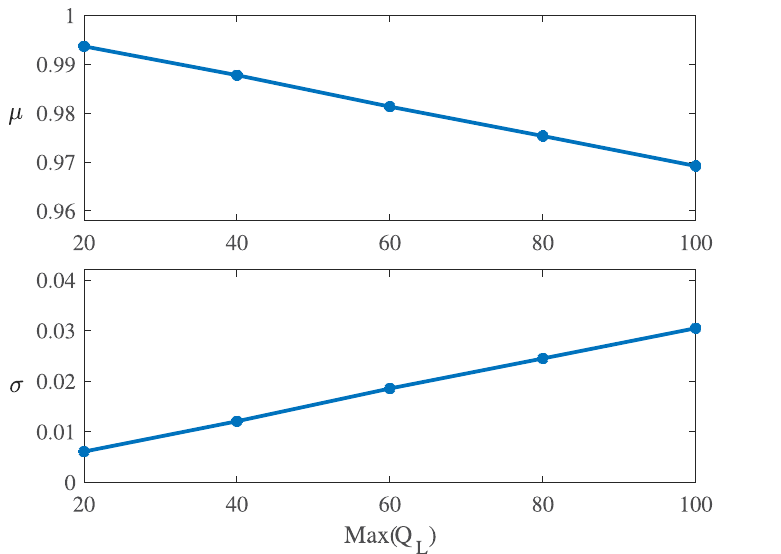
Fig 11. Estimated parameters for Experiments L1 and